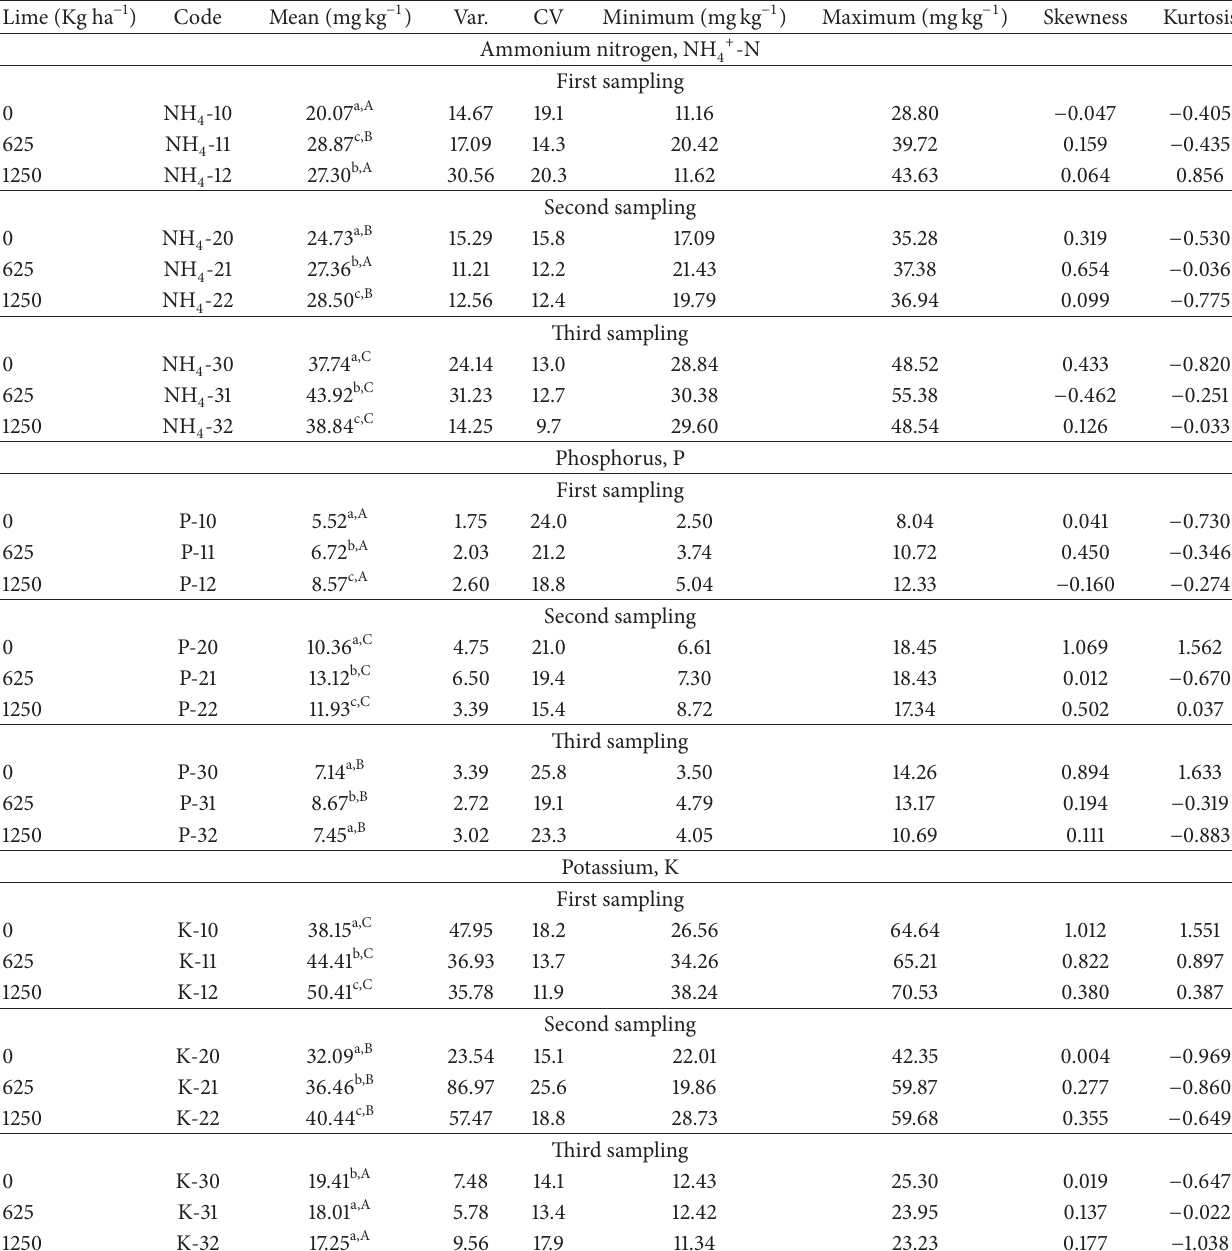
+ -N, P, and K concentrations on different sampling dates and liming treatments (Var.: variance; CV: Table 2: Summary statistics for NH 4 coefficient of